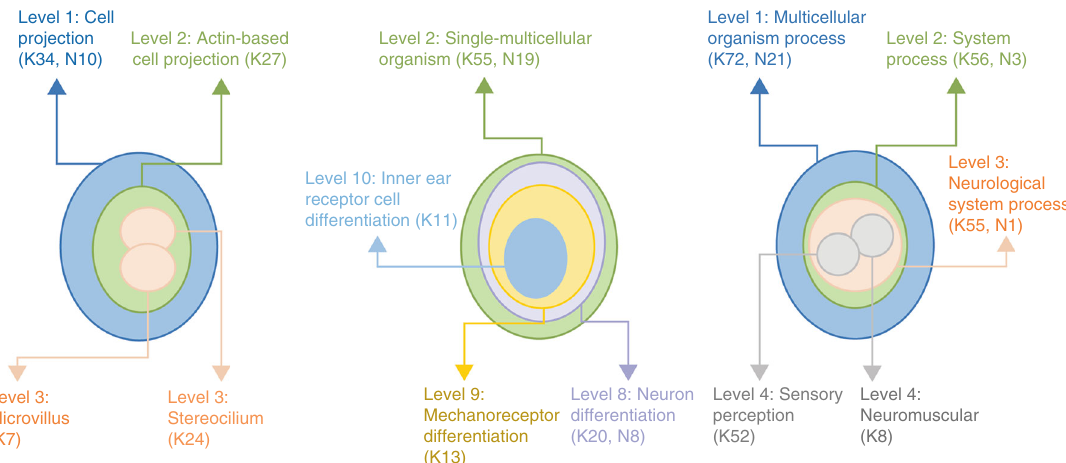
Fig. 4 Distribution of IMPC known and IMPC novel hearing loss genes on three different gene ontology-directed acyclic graphs. Over-represented gene ontology terms for a joint data set of IMPC known (K) and IMPC novel (N) hearing loss genes were identi fi ed using gPro fi ler (Supplementary Table 4). The number of genes associated with any given term were counted and split into known and novel groups. Manual inspection of the enriched gene ontology terms and the gene count highlighted examples, where IMPC novel candidate genes were depleted at the lower ontology level. Here we show three examples of enriched gene ontology terms mapped onto their respective directed acyclic graphs (DAGs), alongside the number of known and novel candidate genes associated with enriched terms. For instance, the fi rst example shows 34 known genes and 10 IMPC novel genes associated with the